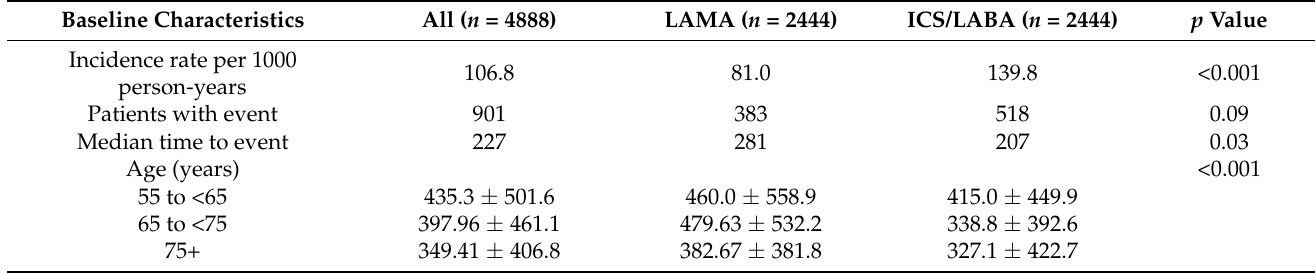
Table 2. Incidence of triple combination therapy and time to triple combination therapy in the propensity score matched